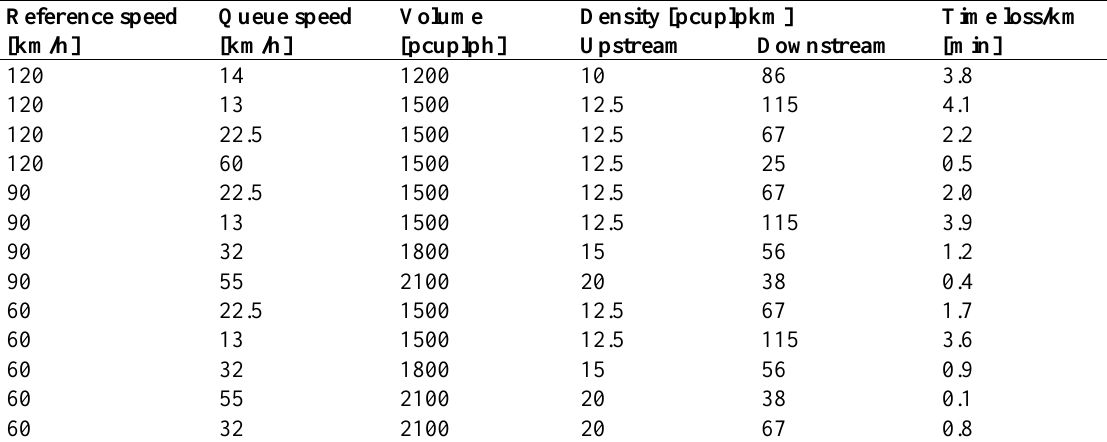
Table 1. Variation of calculated congestion time loss per queue